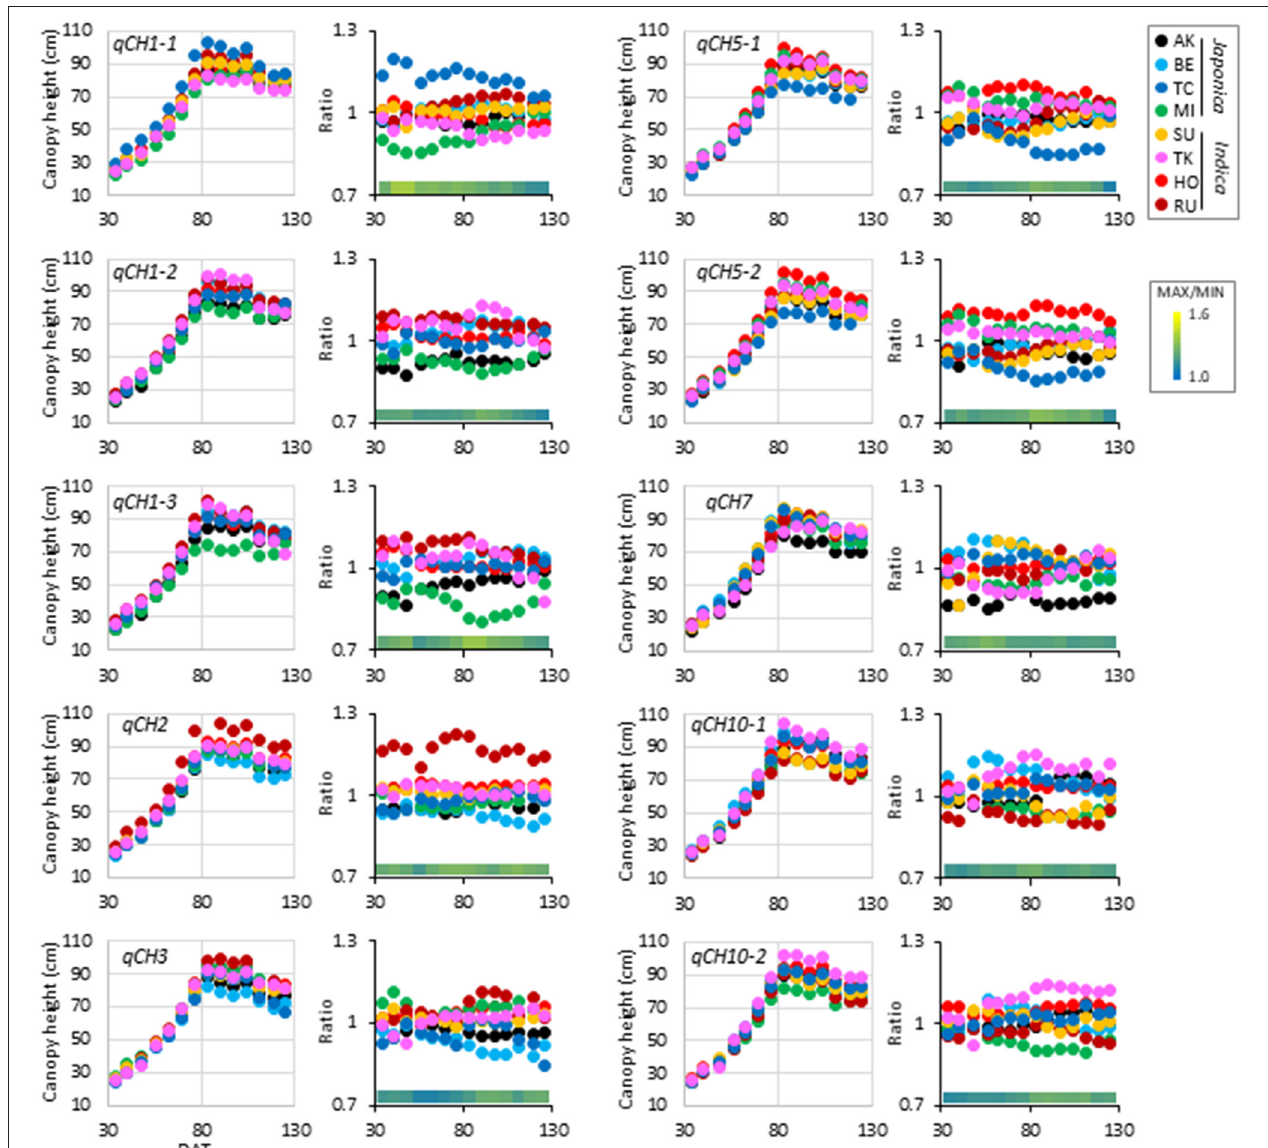
FIGURE 3 | Time-course pattern of haplotype effect on CH at qCH QTLs except for qCH1-4 . Average of haplotype effect on CH (left) and ratio of the haplotype effect to the average values in the JAM lines (right) at each DAT in 2019 were plotted.